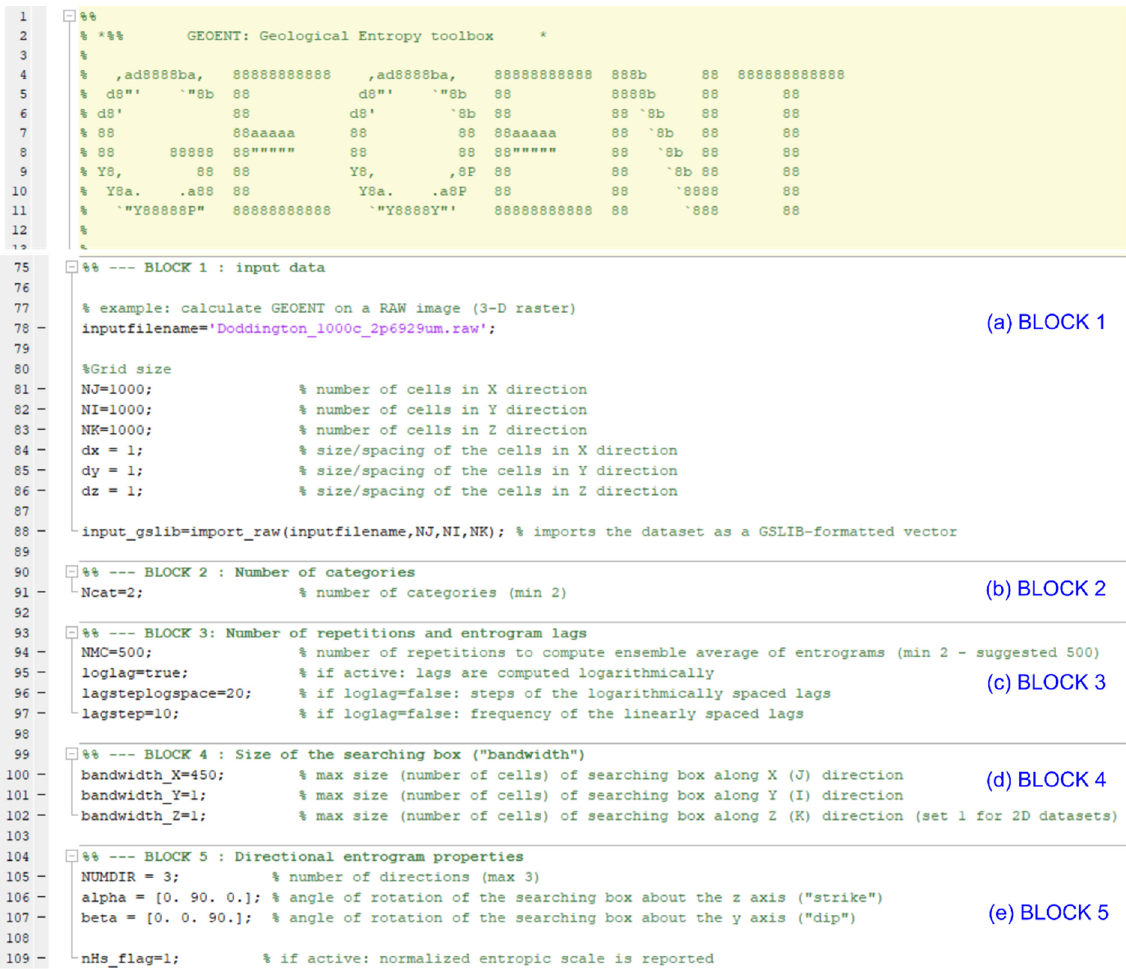
Figure 3. Snapshot of the main script of GEOENT, highlighting Blocks 1 to 5, in which the user introduces the input parameters to perform the calculation.